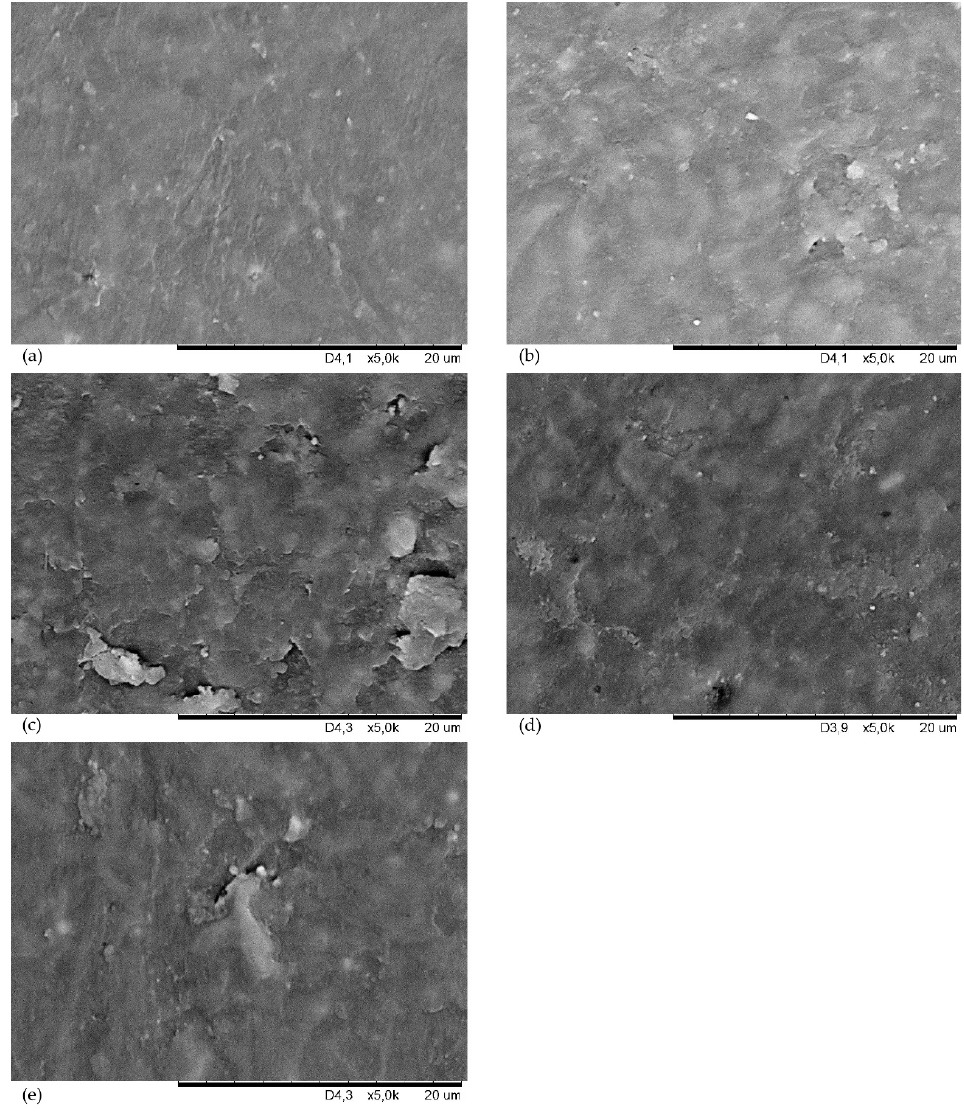
Figure 8. Surface morphology SEM images of CSM43 vulcanizates filled with: arsil ( a ), kaolin ( b ), chalcedonite ( c ), talc ( d ), or carbon black ( e ).